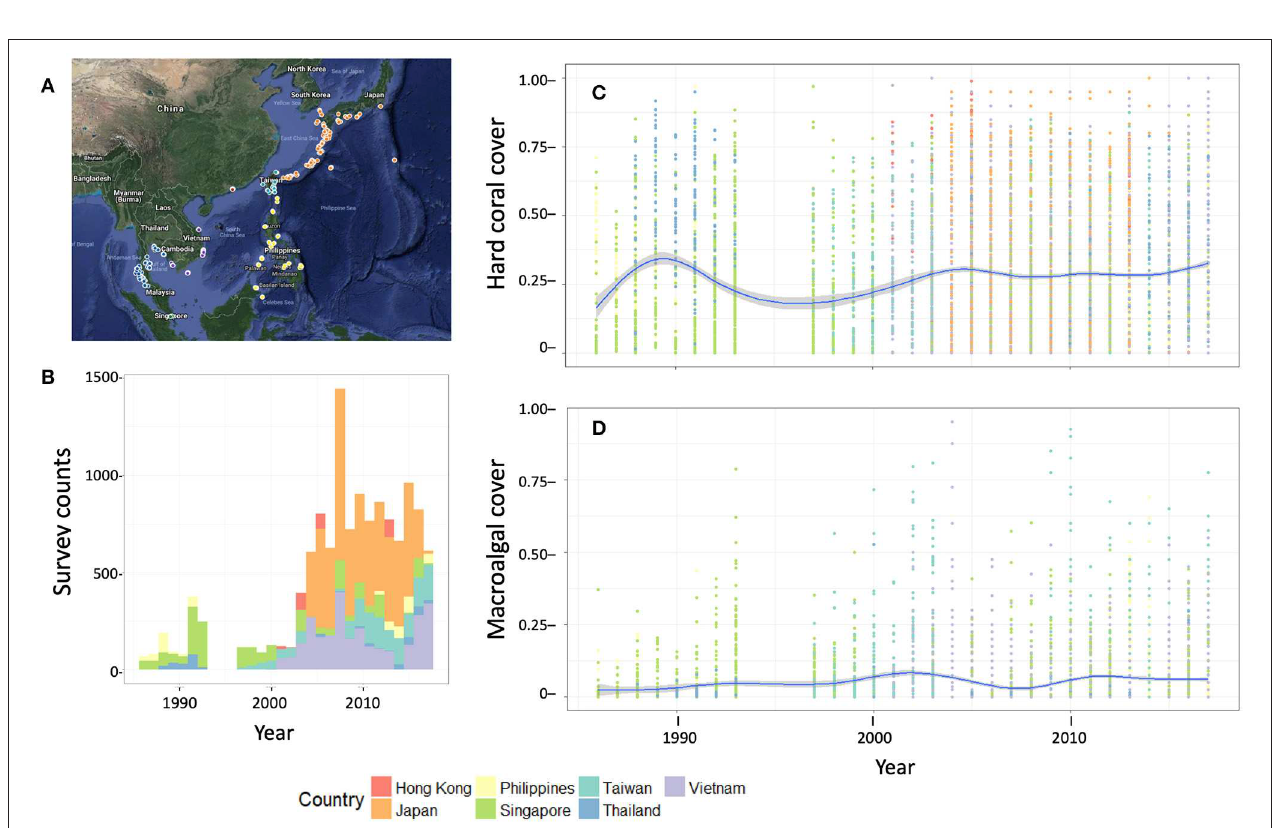
FIGURE 3 | Preliminary results of the GCRMN East Asian region’s pilot analysis of data from 7 countries. (A) Survey sites represented in the dataset, (B) number of sites by country, and (C) hard coral and (D) macroalgal cover by year (mean and 95% confidence interval of the mean, and individual survey points).